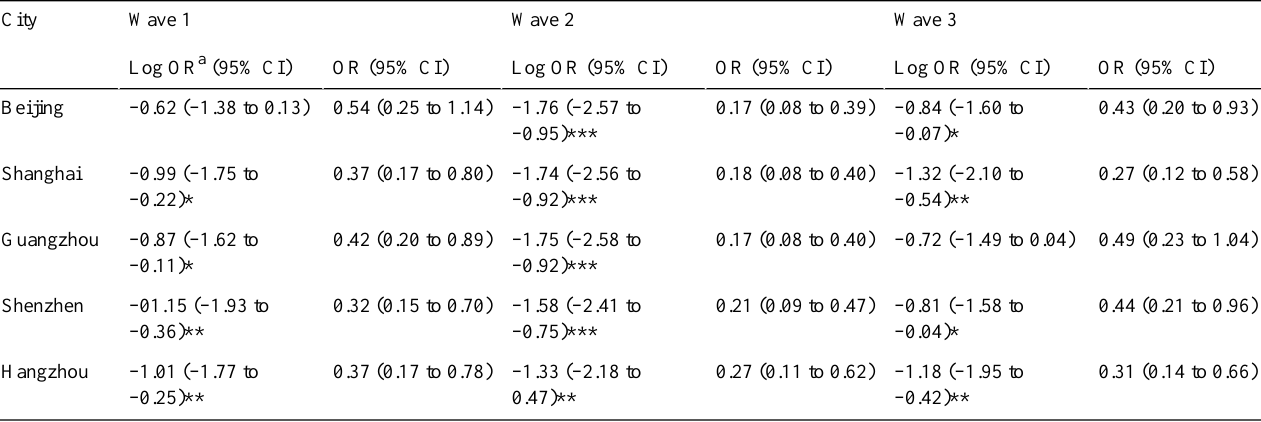
Table 7. City differences in staying at home waves 1, 2, and 3 (Wuhan was used as the reference group).